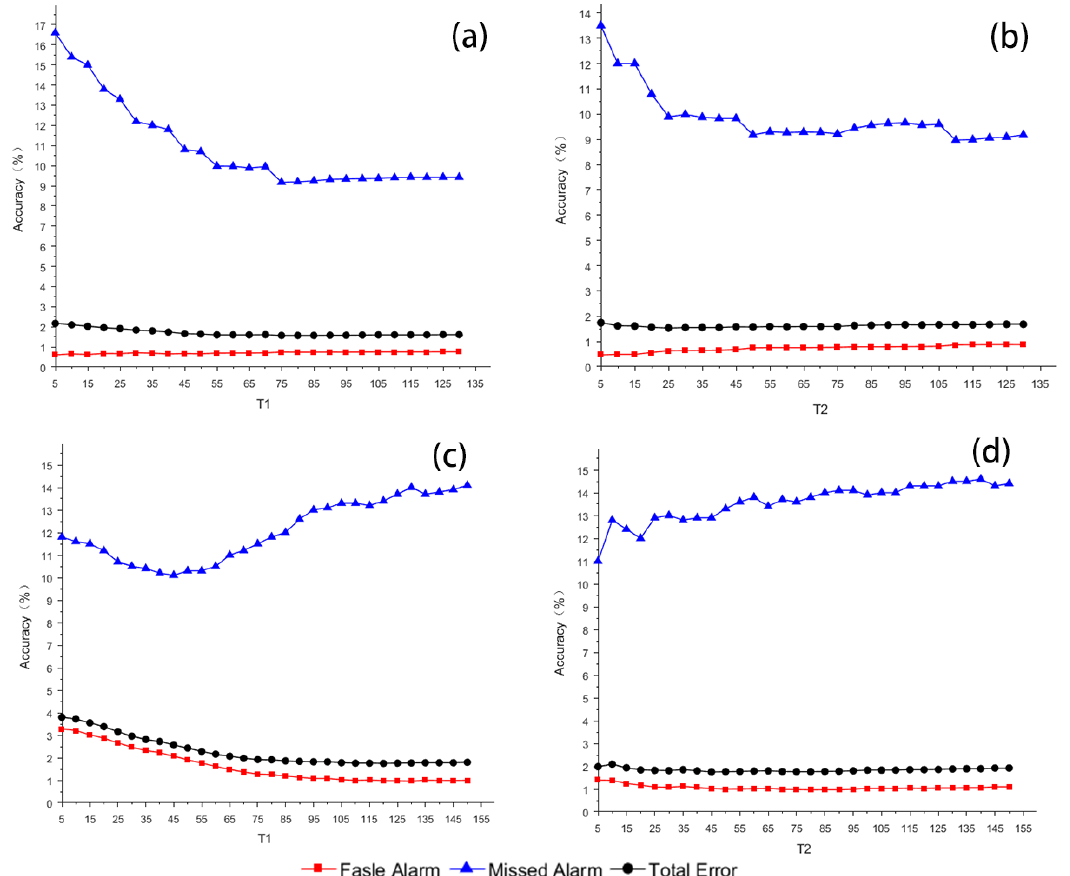
Figure 10. Relationship between detection accuracy and setting of parameters (T 1 and T 2 ) for the proposed approach with Otsu binary threshold in each experiment: ( a , b ) give the relationship between T 1 , T 2 for the Mexico dataset, respectively; ( c , d ) gives the relationship between T 1 , T 2 for the Sardinia Island dataset, respectively.